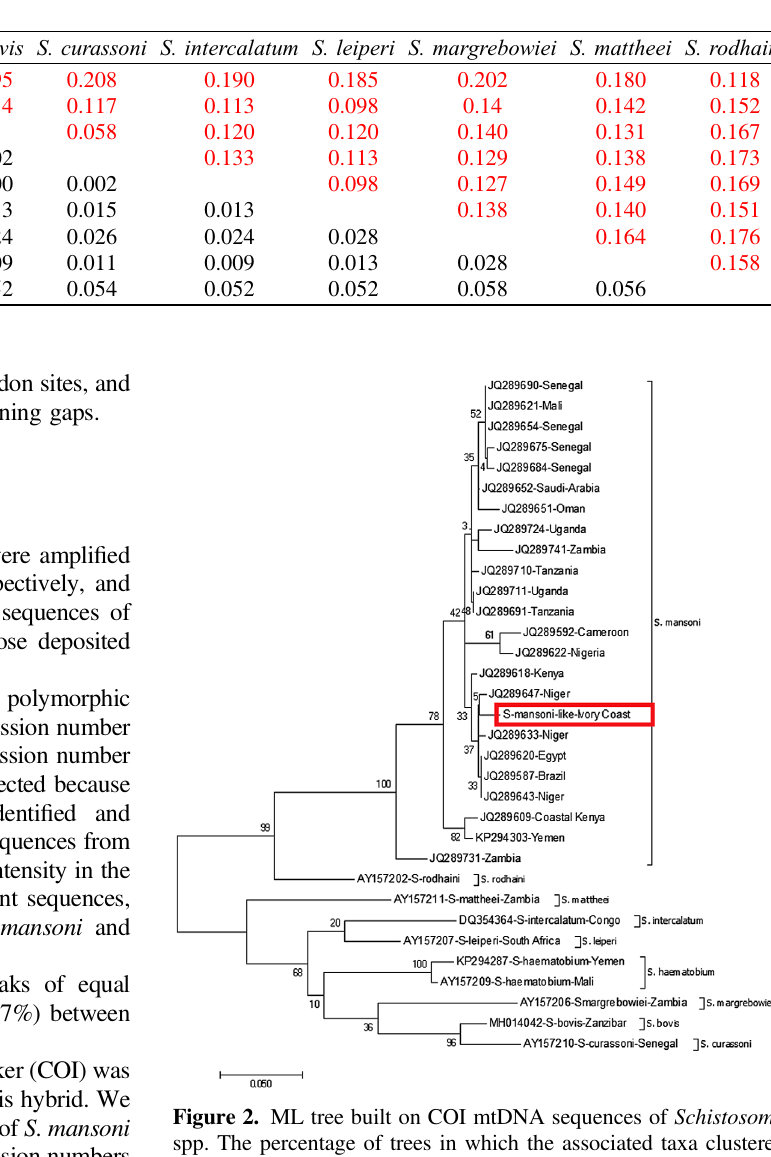
Table 1. Estimates of overall evolutionary divergence across sequence pairs including all nucleotides. The values in black are related to distances between Schistosoma species based on D2 sequences. The values in red are related to distances between Schistosoma species based on COI sequences. The COI intraspeci fi c variability within S. mansoni excluding the hybrid processed in the present study is indicated in green.